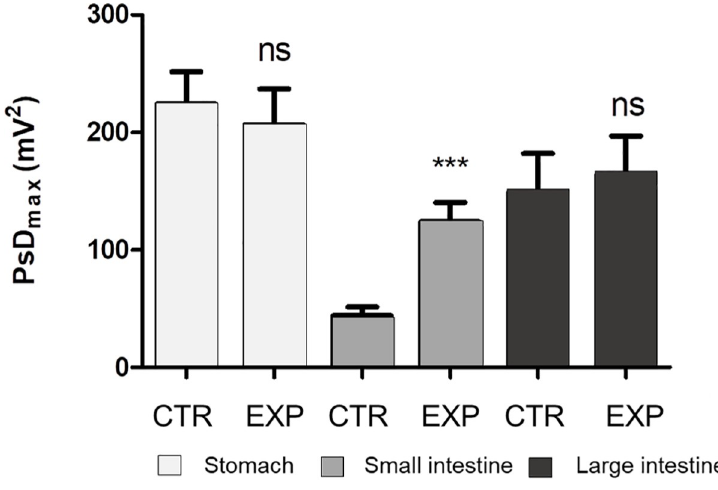
Fig 4. The differences of the absolute values of the maximum of power spectrum density (PsD max , mV 2 ) for the stomach, small intestine and large intestine caused by being fed CTR or EXP diets (n = 9 pigs). ns: non-significant difference between the PsD max values of the CTR and EXP feeding periods; ��� : significant ( P < 0.001) difference between the PsD max values of the CTR and EXP feeding periods; CTR: low level of crude fibre (29 g/kg as in feed), soybean- and maize-based feed; EXP: moderate level of crude fibre (49 g/kg as in feed), soybean- and maize-based feed + 4% Opticell (Agromed Austria GmbH, Kremsmu¨nster,